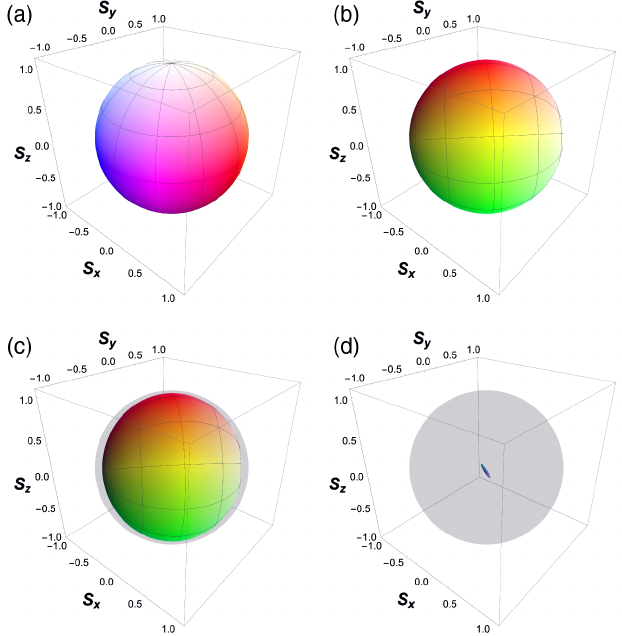
FIG. 9. Tomographic reconstruction of TH unitary operator. From top left to bottom right: (a) initial Bloch sphere of pure states, (b) simulation of that Bloch sphere under ideal TH , (c) experimental reconstruction with correct decryption, and (d) experimental reconstruction with bad